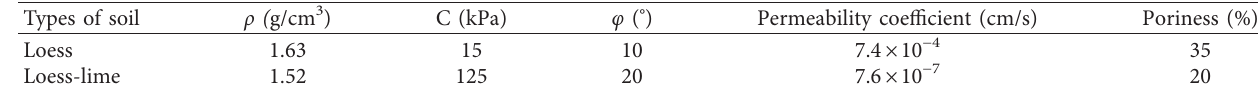
Figure 8: Initial model diagram. Table 6: Parameters used in the model.